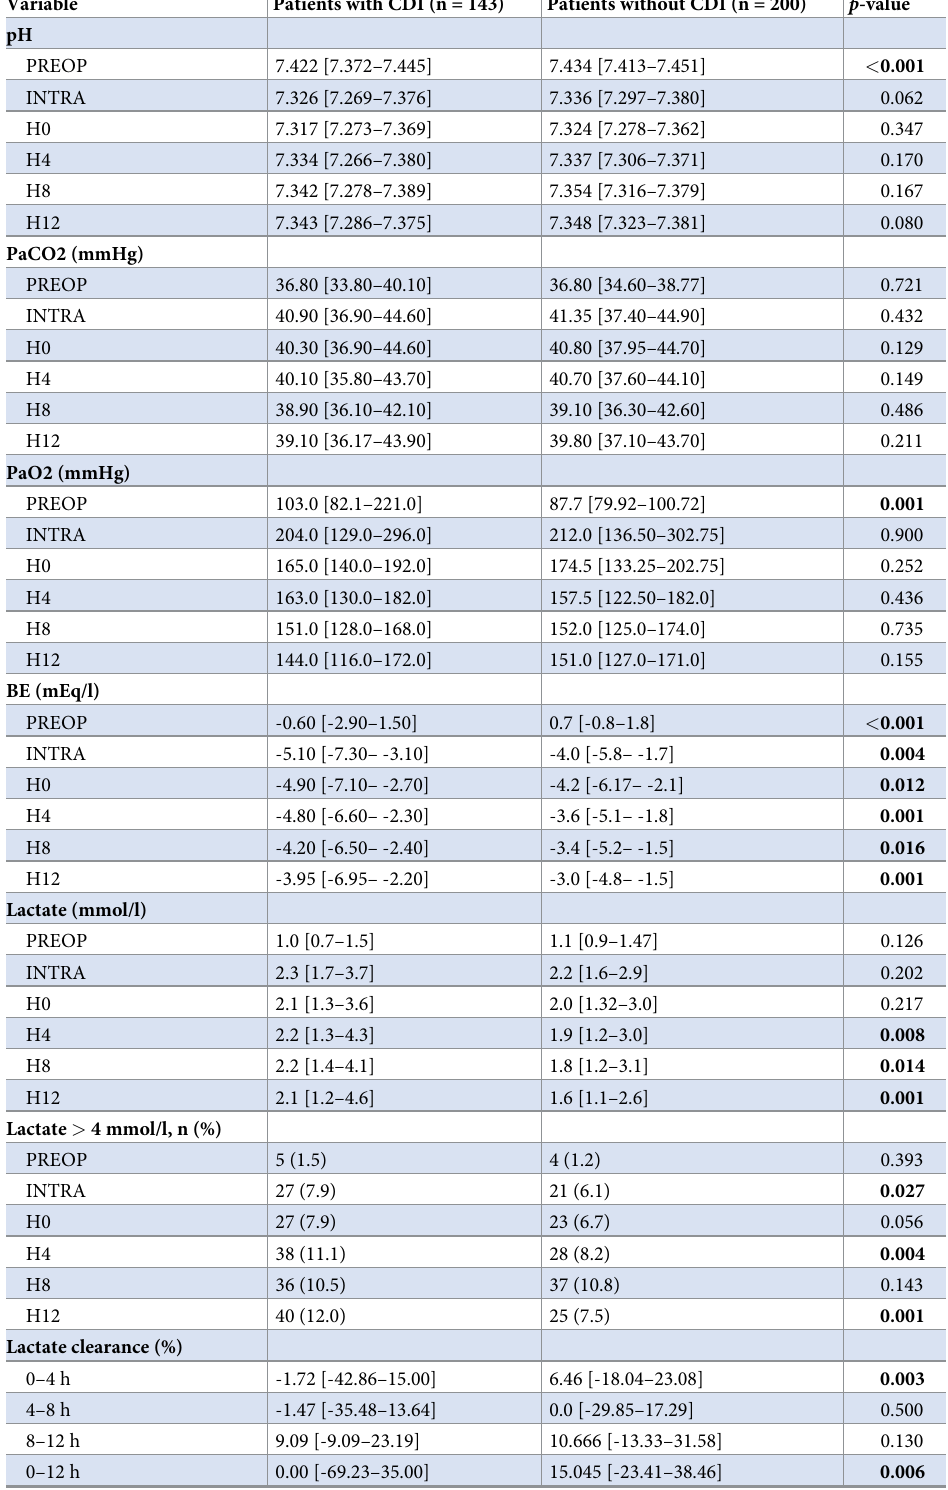
Table 2. Variables of acid-base balance in both analyzed